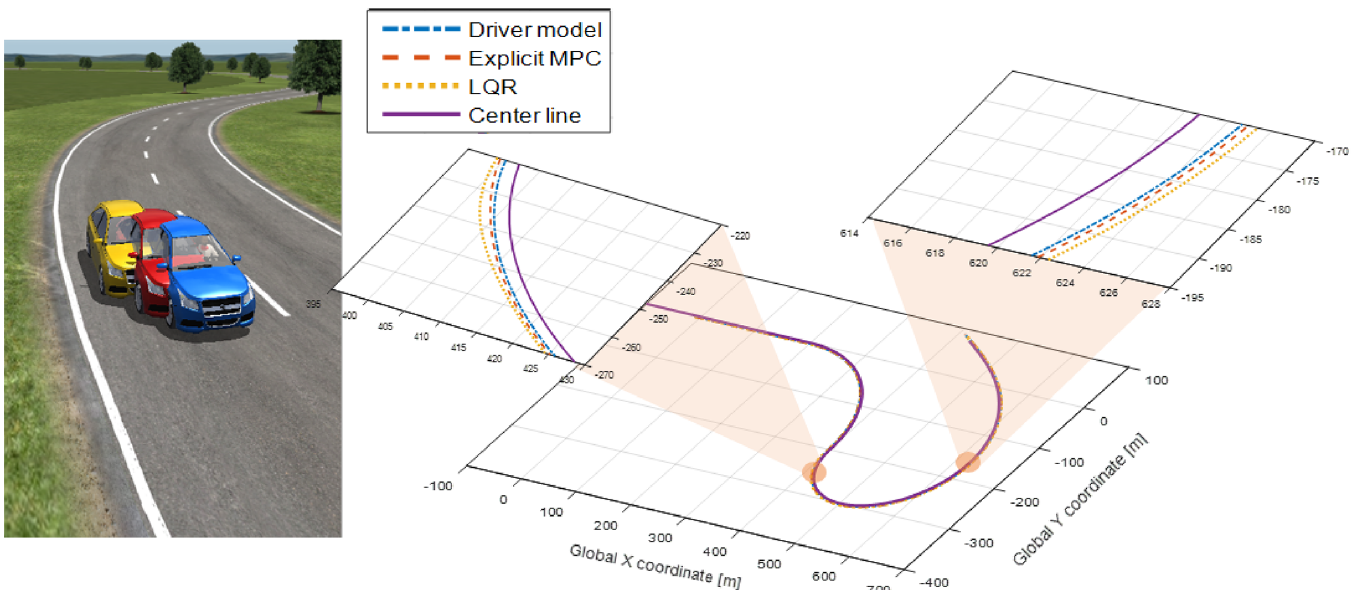
Fig 8. Paths of controllers and driver model. This figure shows the paths of the LQR controller, explicit MPC controller, and driver model. It can be observed that in the case of the LQR controller, the deviation from the center line of the desired path is larger than that in the case of the explicit MPC controller, whereas path-following control performed using the explicit MPC controller is similar to that performed using the driver model in CarSim. The details of the error variables are shown in Fig 9.